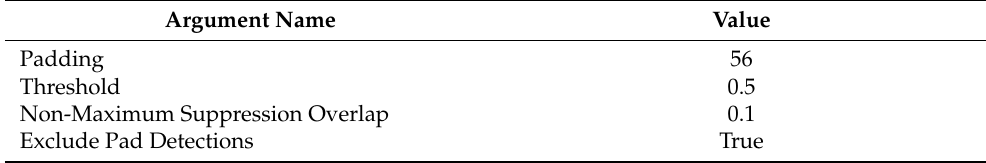
Table 4. Arguments used for detecting the